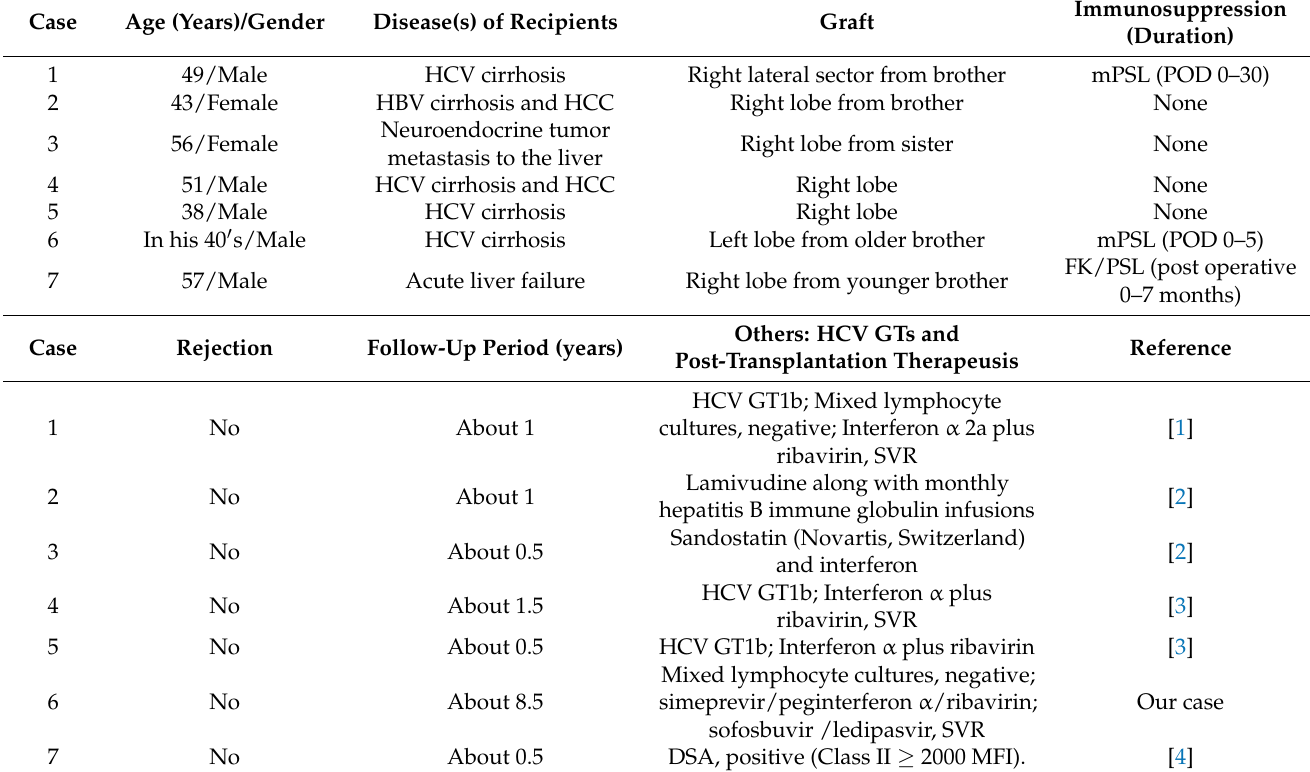
Table 3. Seven reported cases with living-donor liver transplantation from human leukocyte antigen- matched sibling